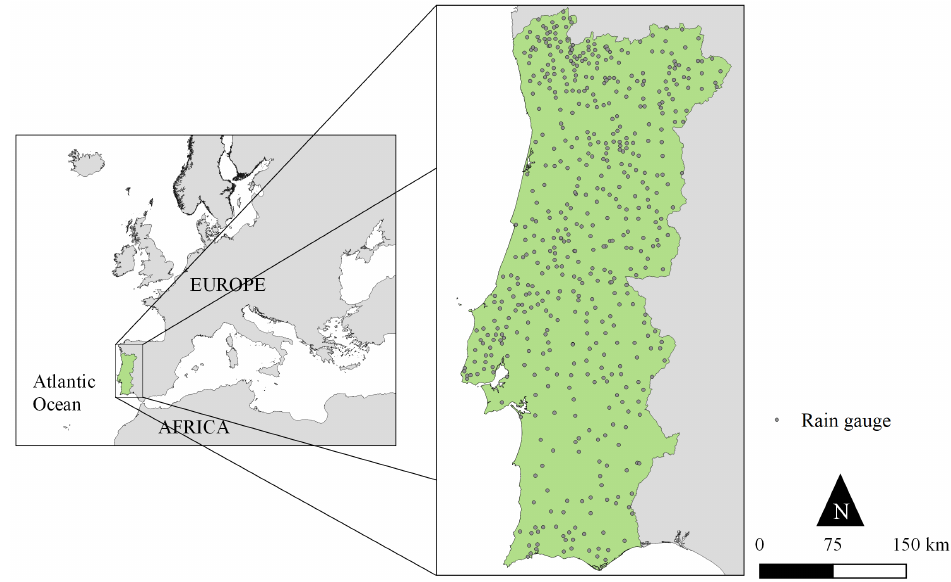
Figure 1. General location of mainland Portugal and of the rain gauges with complete monthly data in the period of 106 years, from 1913/1914 to 2018/2019 used in the study (532 rain gauges).